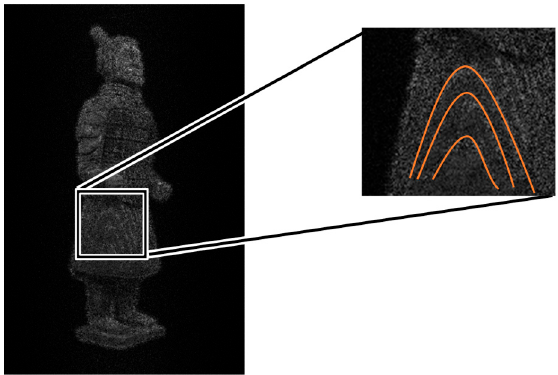
Figure 7. Layering Terra-Cotta Warrior model, thickness of layering set at 5 mm, and the inappropriate fringes are redisplayed on the model.